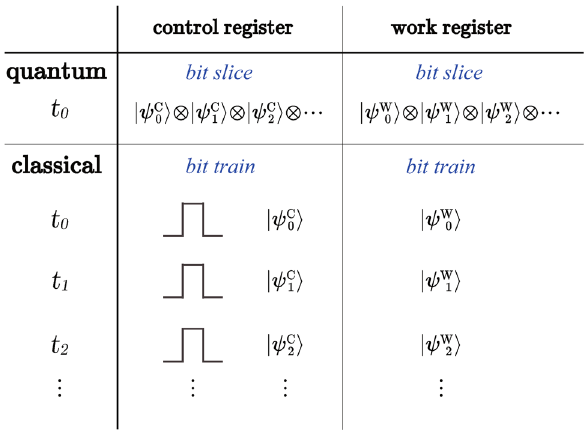
H V and directions in each pulse are | � | �